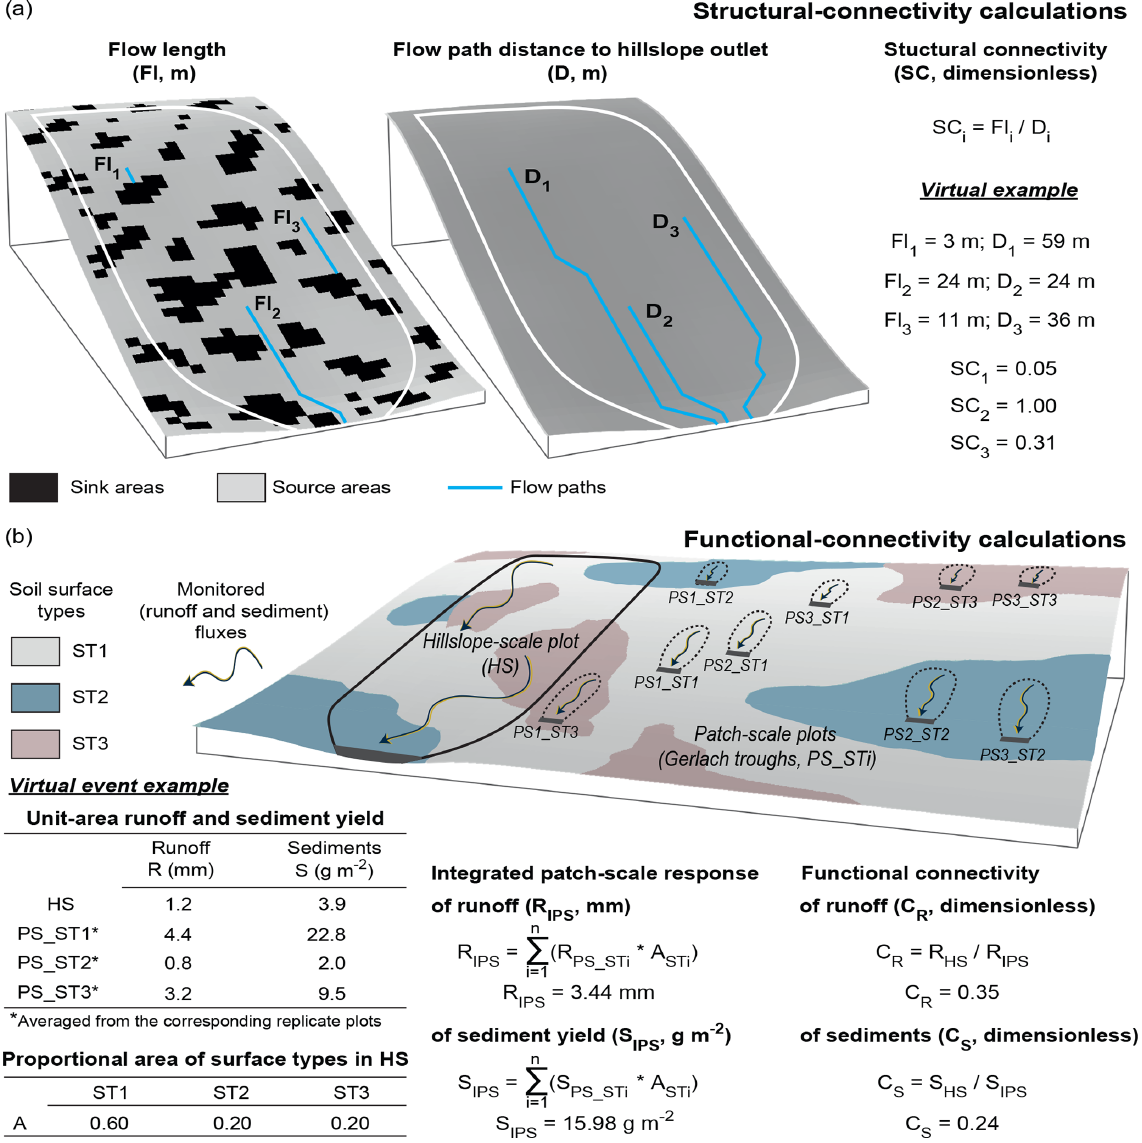
Figure 2. Schematic representation and virtual examples of the calculations for the quantification of (a) structural connectivity (SC) and (b) the functional connectivity of both runoff ( C R ) and sediments ( C S ). Structural connectivity for any location in the hillslope (SC i ) is calculated as the ratio of flow length (Fl i , length of the runoff path until a sink is reached downslope of the hillslope location) to the (topography-based) flow path distance of the location to the hillslope outlet ( D i ). For each precipitation event, functional connectivity of runoff, C R (of sediments, C S ), is calculated as the ratio of hillslope-scale runoff, R HS (sediment yield, S HS ), to the integrated (i.e. area- weighed) patch-scale production of runoff, R IPS (of sediments, S IPS ). The virtual slope in (b) includes three replicate PS_ST patch-scale plots for each of the three displayed STi soil surface